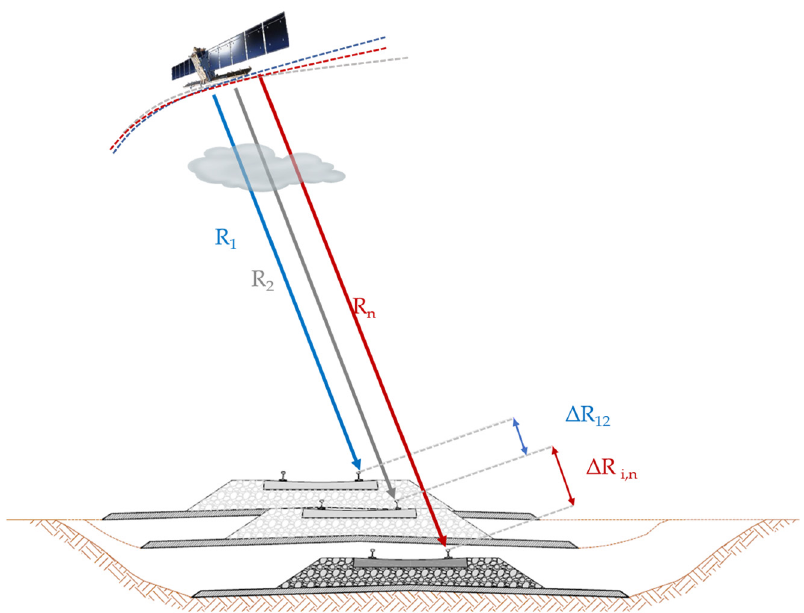
Figure 6. Scheme of the displacement detection by the PSI technique through n images collected on the same area: R i is the sensor–to-target distance of the i th acquisitions, ∆ R i is the variation with respect to the previous image.